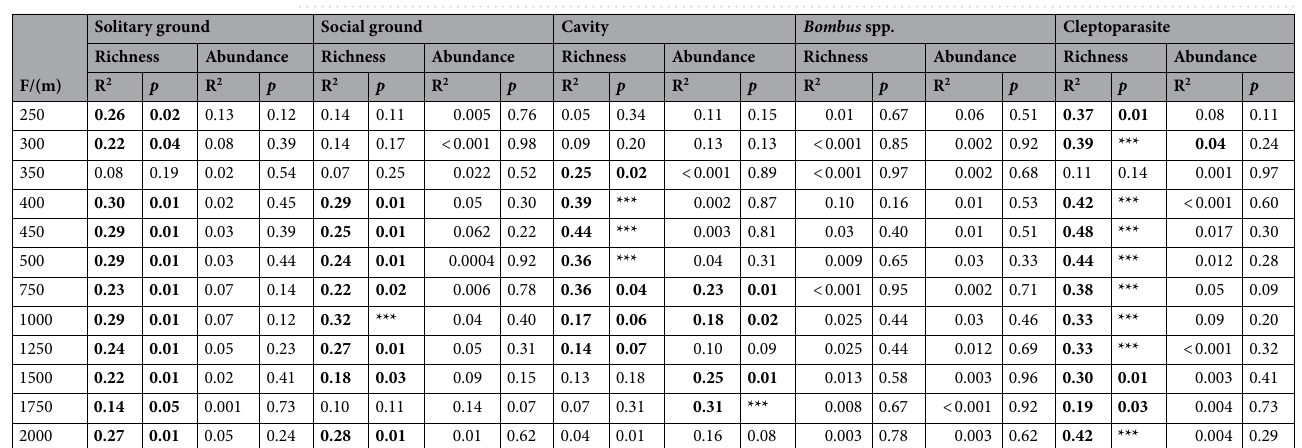
Table 1. Species richness and proportional abundance, for each of the five functional guilds: solitary ground nesters, social ground nesters, cavity nesters, bumblebees ( Bombus spp.) and cleptoparasites in relation to the total amount of pollinator habitat at each spatial scale. F is the spatial scale (m) from each site. Significant results are shown in bold (alpha = 0.05), p values < 0.005 represented by *** due to space constraints in